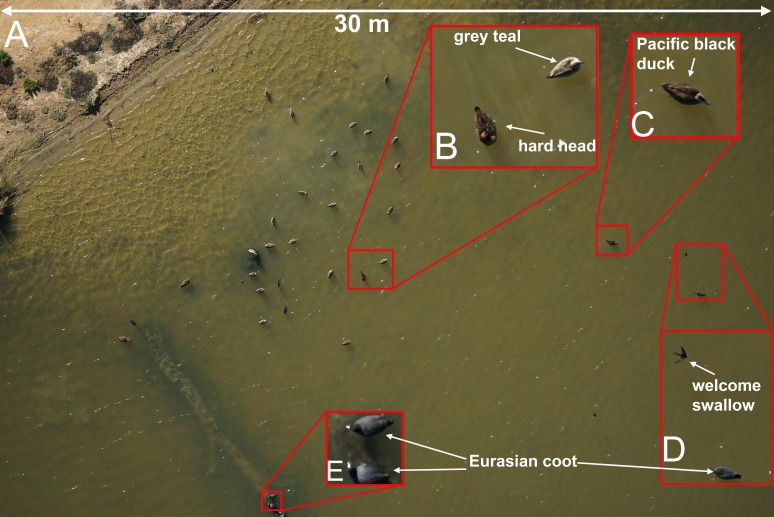
Examples of images taken using the Sony A7-R digital camera.Species that are similar in size and shape can be clearly differentiated in photos taken from 50 m above the flock with a 70 mm lens (A, B and C). Smaller birds such as swallows and coots can also be easily identified (D and E). The area footprint of this image is 30 m × 20 m with ground coverage of 7.2 mm/pixel. This image was captured with an ISO = 200, shutter speed = 1/640 s and f-stop = 6.3.